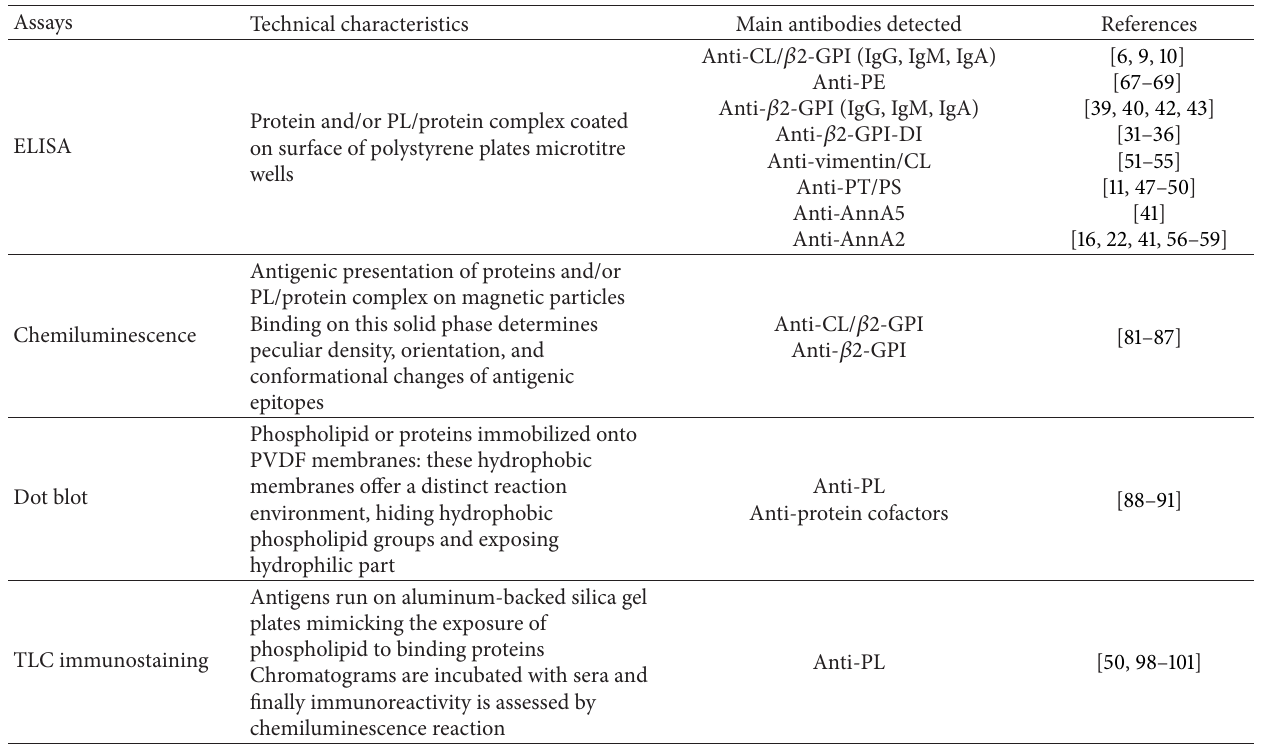
Table 1: Different technical approaches for aPL